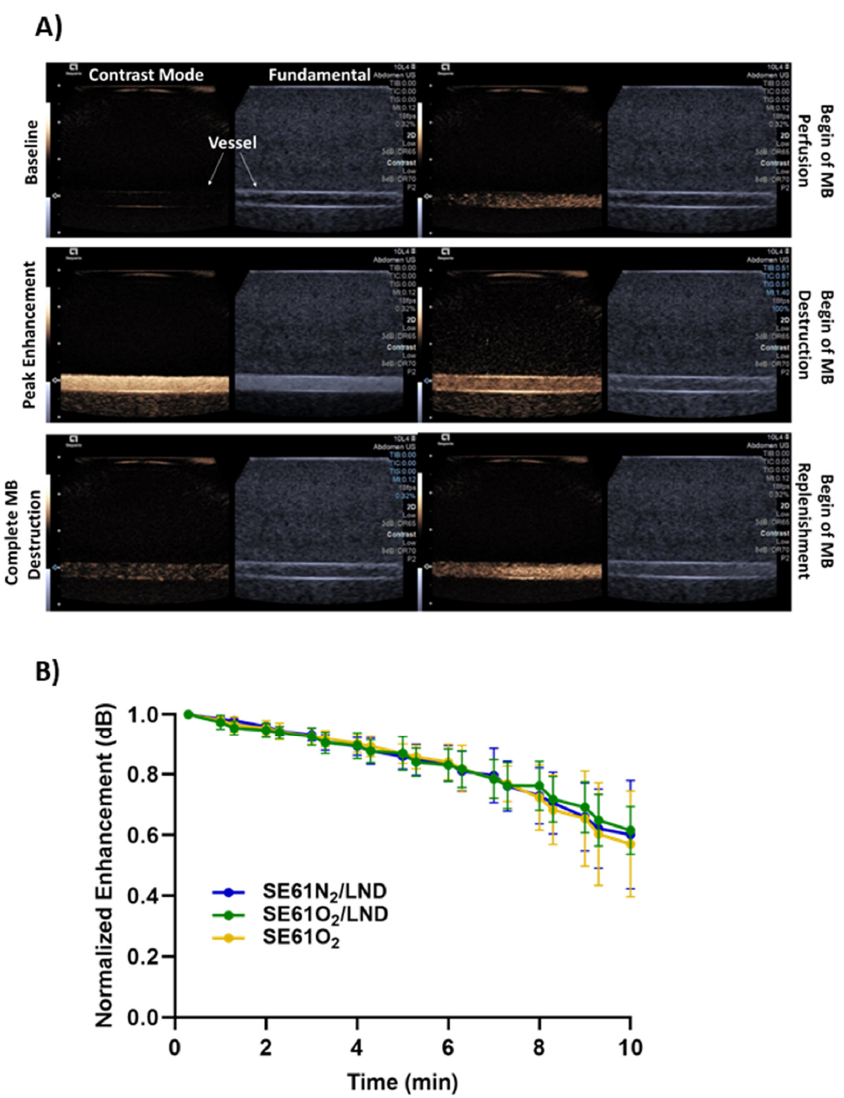
Figure 2. ( A ) Illustrative ultrasound images of SE61O 2 /LND in a closed-loop flow phantom showing contrast mode ( left ) and fundamental (B-mode) ( right ). Image depth markers correspond to 0.3 cm increments with the flow direction from right to left. ( B ) Microbubble stability curves of SE61O 2 /LND (green), SE61O 2 (yellow), and SE61N 2 /LND (blue) at a non-destructive MI (MI = 0.12). No statistically signi fi cant di ff erences among formulations were observed in vitro ( p = 0.99). Imaging and tolerability in the HNSCC tumor model in vivo showed that all mi- (SE61O 2 , SE61O 2 /LND, and SE61N 2 /LND), were well tolerated following intravenous in-